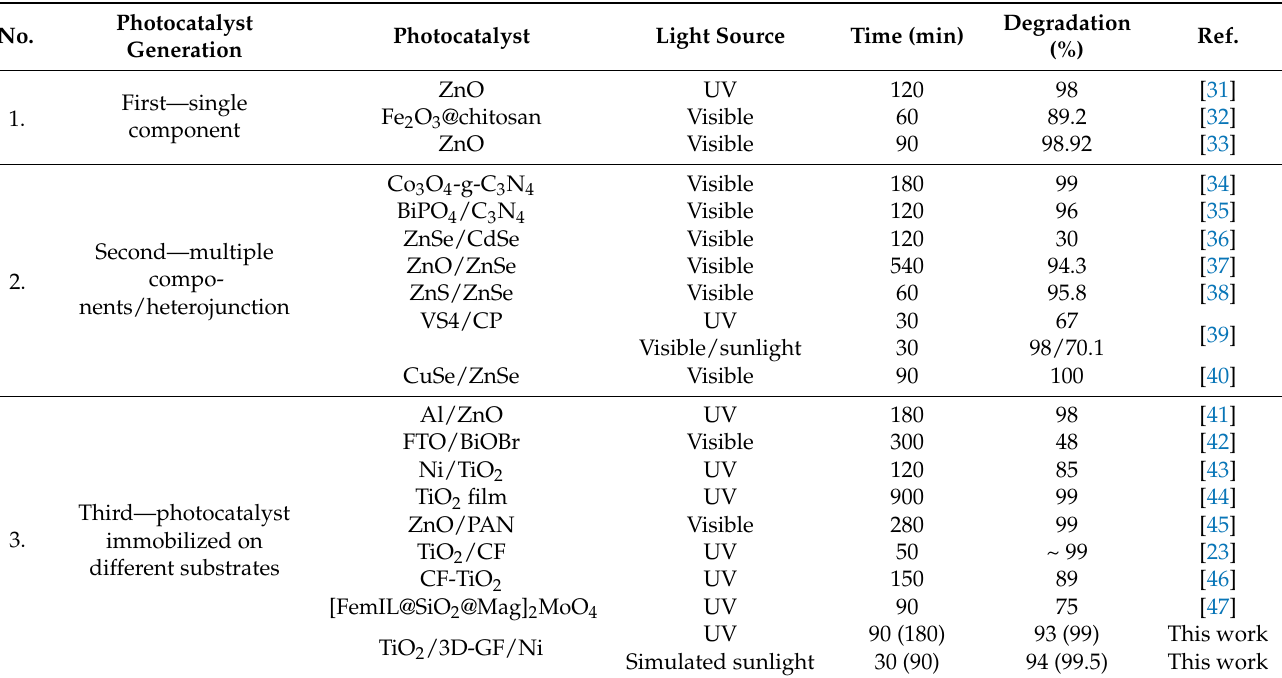
Table 1. The efficiency of the most representative photocatalysts for methyl orange